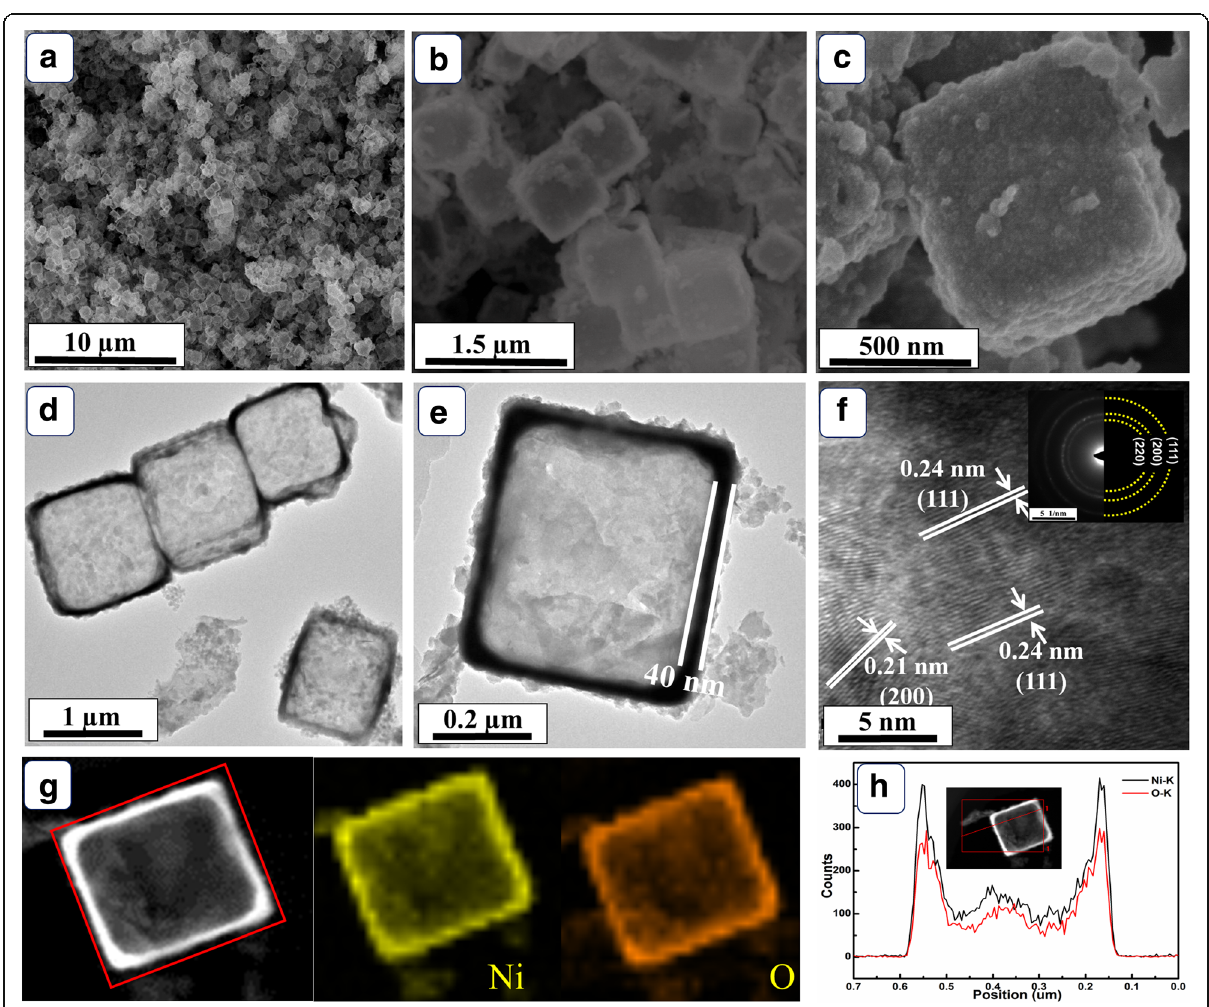
Fig. 2 a – c SEM and d , e TEM images of NiO HPA. f The HRTEM image of NiO HPA. g The STEM and EDX mapping images of a NiO HPA cube. h The line-scan EDX spectra of a NiO HPA